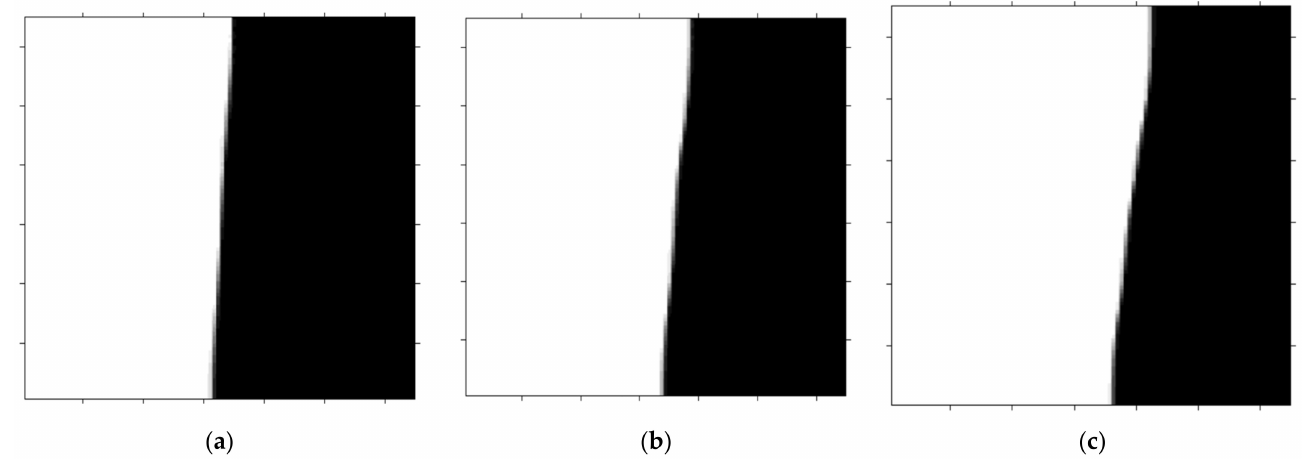
Figure 5. Interface positions in the Ibrahem et al. [8] study. ( a ) Pure water, ( b ) nano-PCM No.1, and ( c ) nano-PCM